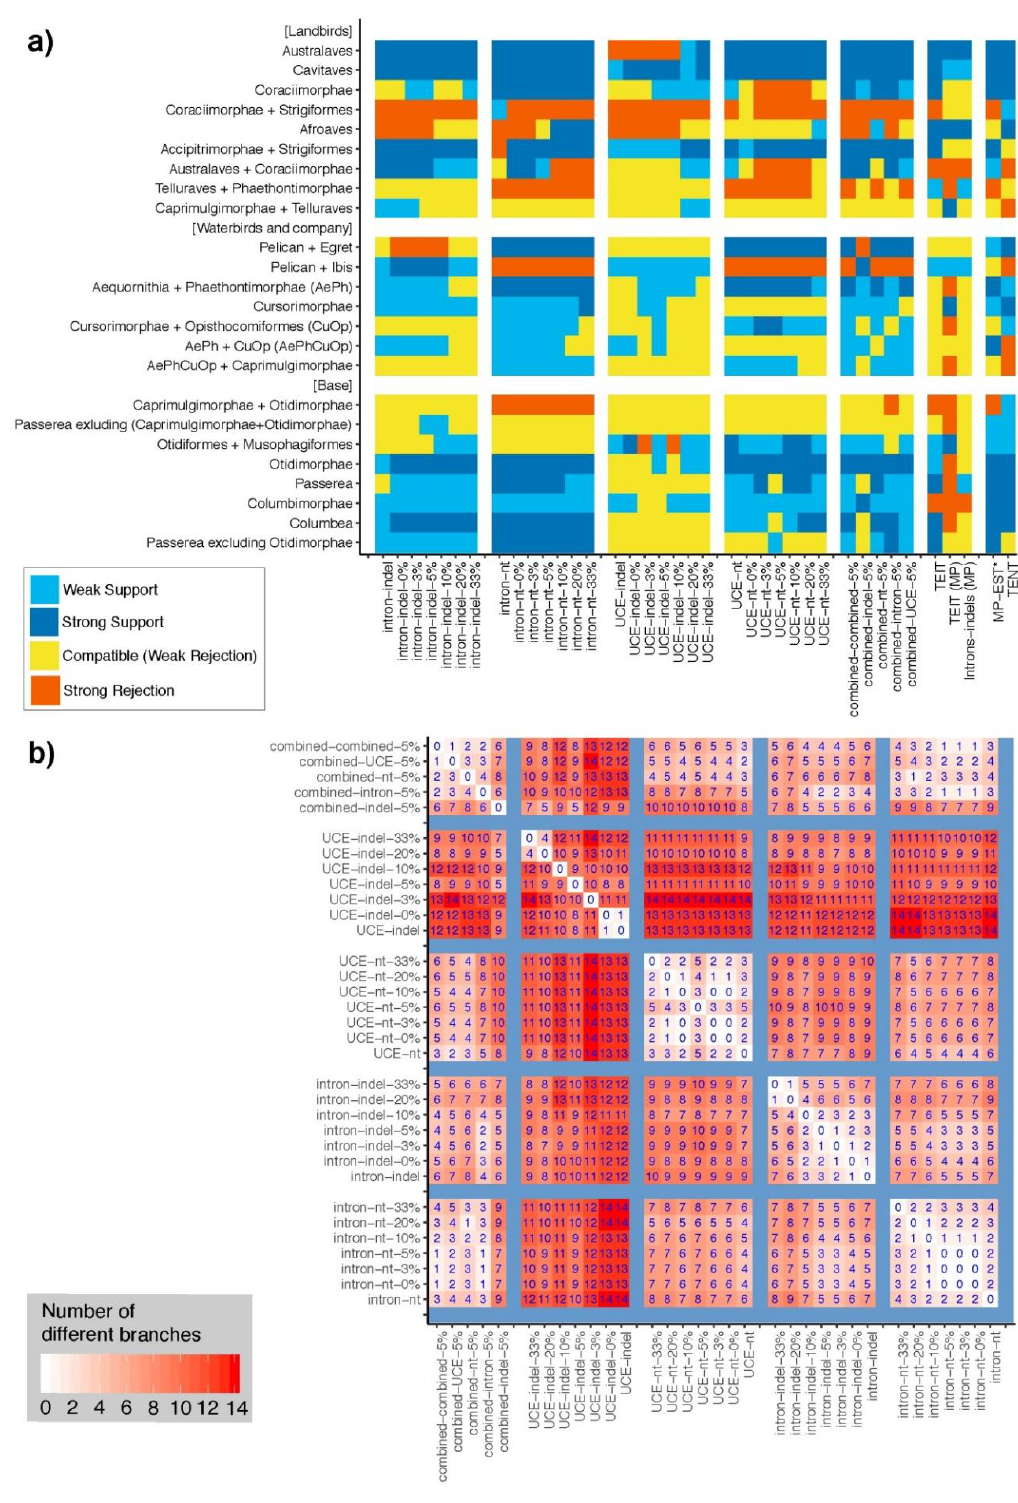
Figure 9. ( a ) For each focal relationship (i.e., those with some conflict), we show whether they are recovered or rejected in various trees with high or low support, defined by a threshold of 95% support. Three relevant trees from the Jarvis dataset and two MP indel trees are also included. Note that support values are localPP for ASTRAL trees and BS support for concatenation trees, including those from Jarvis et al. [15]. See Figure 1 for clade names. Figure created using DiscoVista. ( b ) The number of different branches between all pairs of ASTRAL species trees.